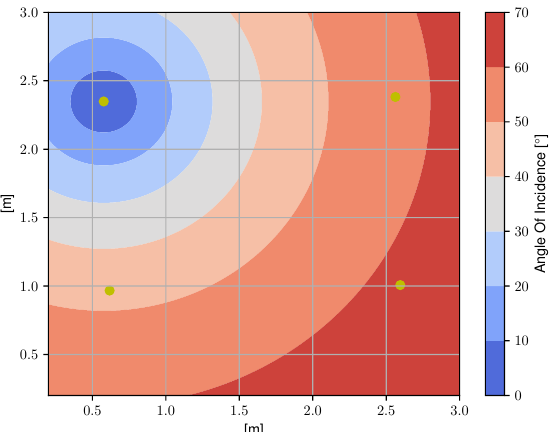
Figure 5. A top view of the set-up with the angles of incidence γ l at the photodiode (PD) highlighted for a single LED. The wide range of angles of incidence results in a representative experimental set-up.